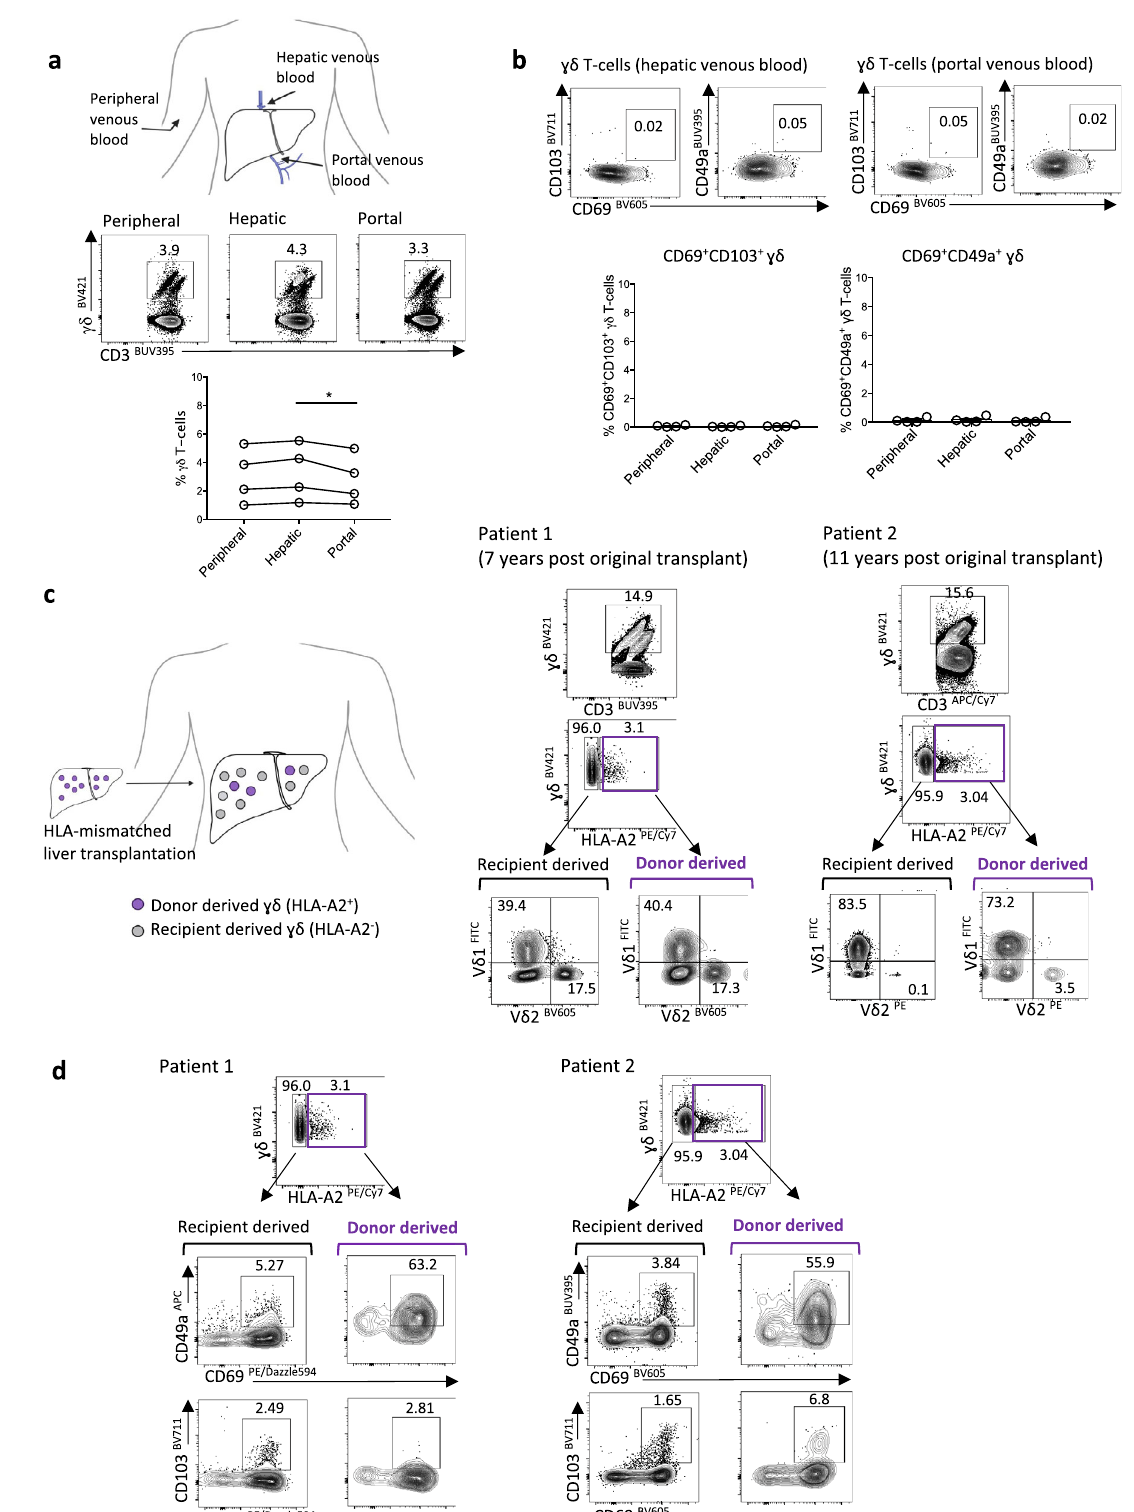
mulation (Fig. 3c, Supplementary Fig. 3c). The majority of V δ 1 and V γ 9V δ 2 T RM also produced the anti-tumour cytokine IFN-